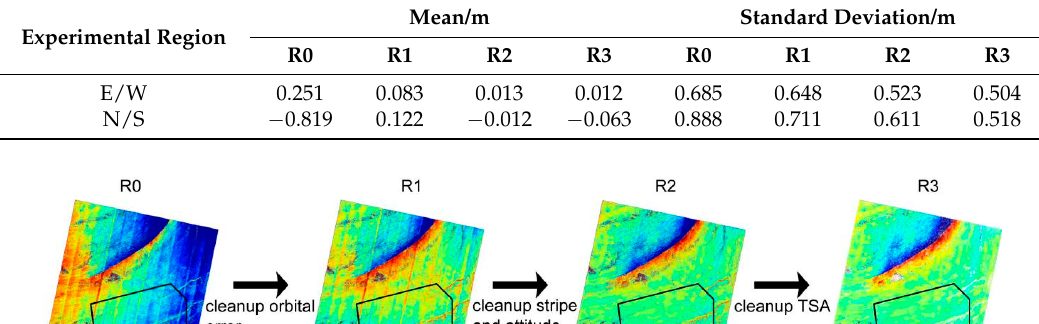
Table 3. Accuracy evaluation results.